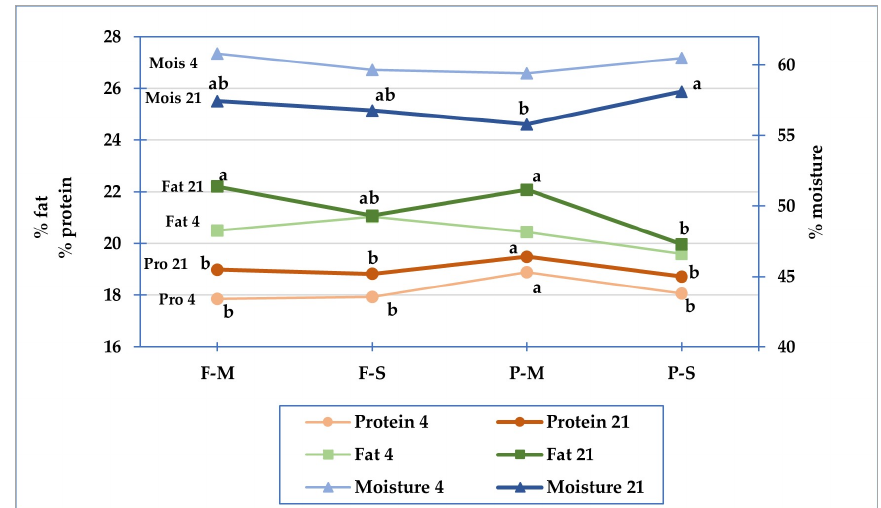
Figure 1. Moisture (Mois), protein (Pro) and fat content in cheese after 4 and 21 days of storage, made from the four different types of milk. F-M: fresh minimally pasteurized milk; F-S: fresh strongly pasteurized milk; P-M: pre-treated minimally pasteurized milk; P-S: pre-treated strongly pasteurized milk. For each parameter, different letters in the graph indicate significant differences ( p < 0.05).